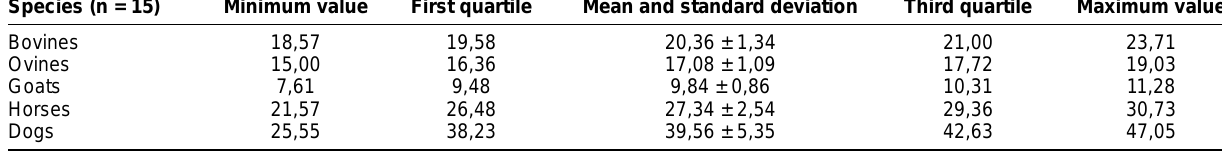
2 Table-3. Terminal values, averages, standard deviation and quartiles of the surface of red blood cells of pets (expressed in µm ).